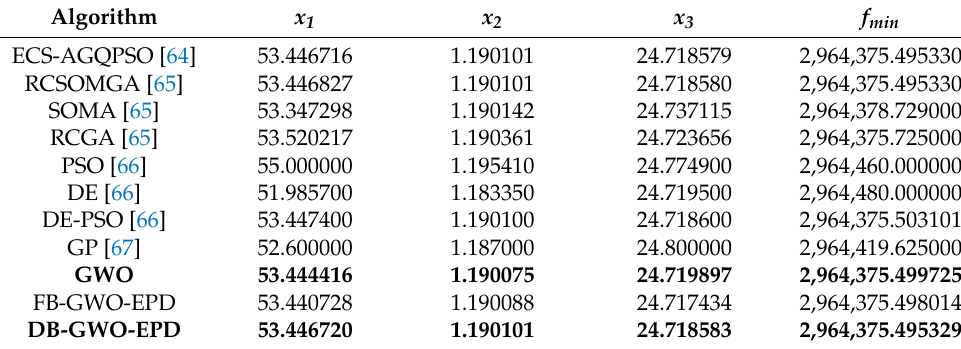
Table 12. Results of solving gas transmission compressor design